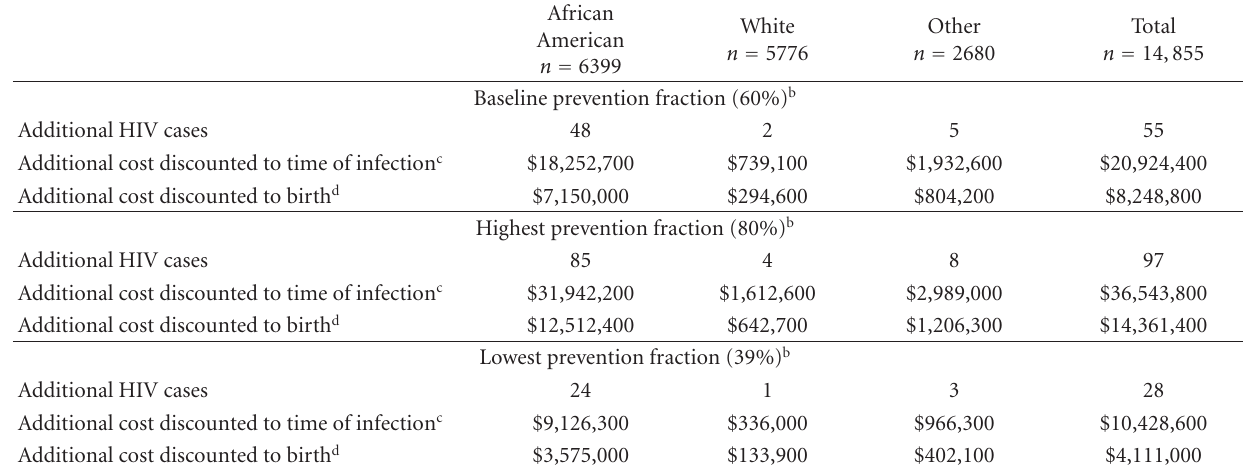
Table 4: Projected additional male cases of HIV and additional direct medical costs a .